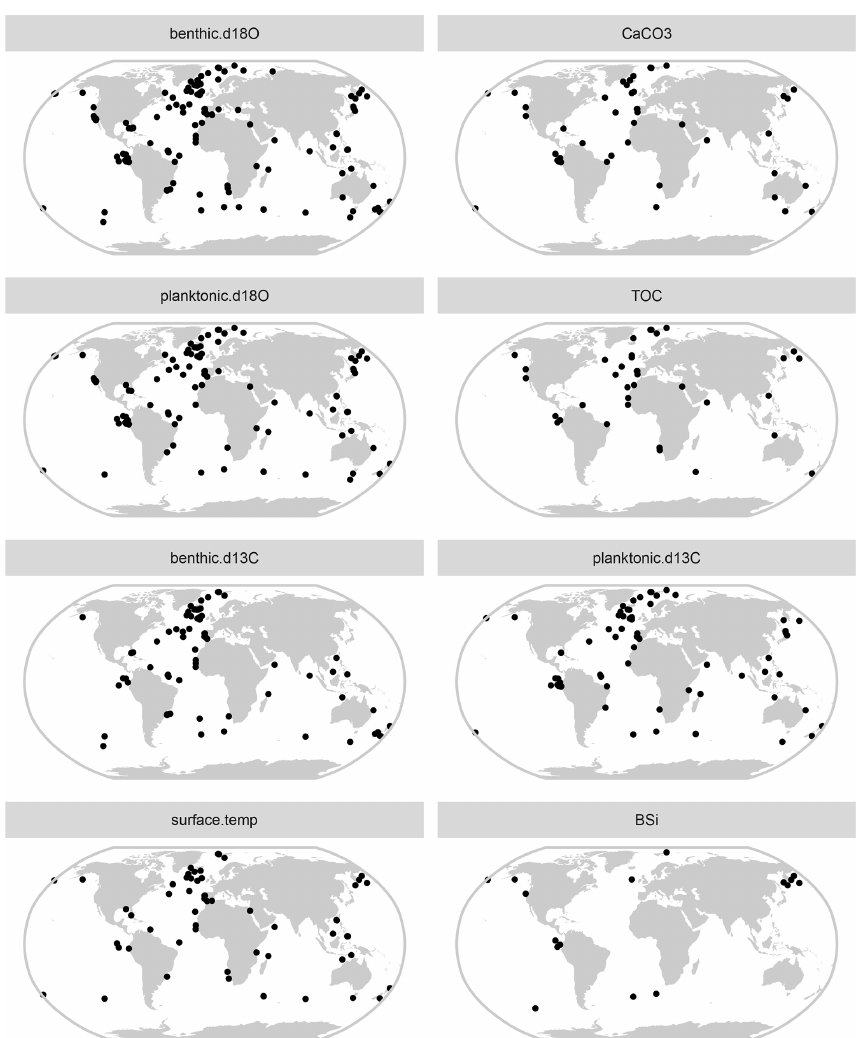
Figure 3. Spatial distribution of sites in version 1.0.0 of the PalMod 130k marine palaeoclimate data synthesis. The distribution of the sites reflects research effort and the possibility of obtaining sediment cores containing well-preserved foraminifera and is hence skewed towards the Northern Hemisphere (Atlantic) and the continental margins. Since no explicit search was carried out for parameters other than benthic foraminifera δ 18 O, the distribution of the other parameters is restricted to sites that have benthic foraminifera δ 18 O. For benthic foraminifera δ 13 C, only sites with data based on the genus Cibicidoides are